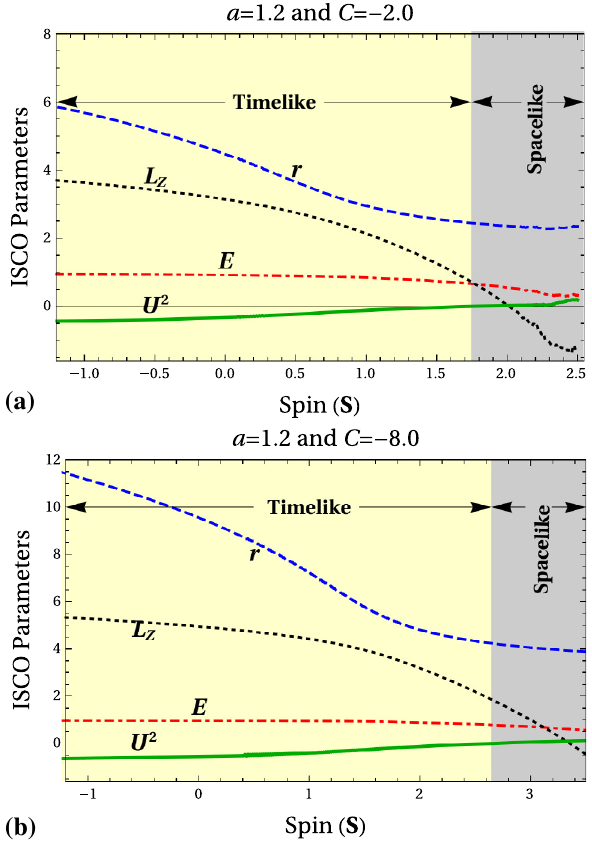
Fig. 5 Behavior of ISCO parameters ( r , E and L z ) and superluminal constraint ( U 2 ) as a function of spin ( S ) for the spinning test particle in the rotating braneworld BH for counter-rotating ( J z < 0) cases. Here, M equals to